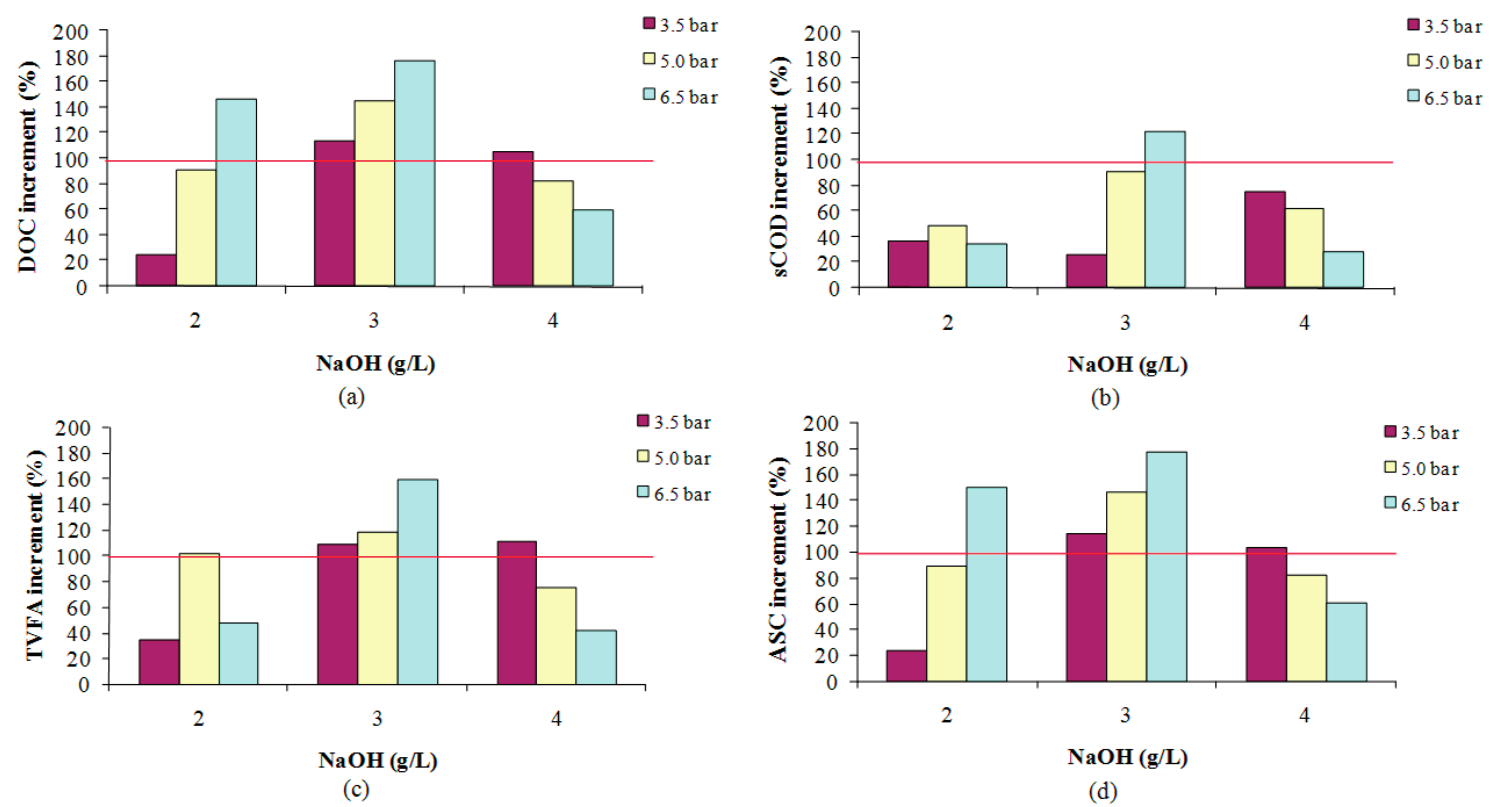
Figure 2. Effect of the NaOH additions on the SY, expressed in terms of DOC ( a ); sCOD ( b ); TVFA ( c ) and ASC ( d ), at 160 °C and 30-min operation